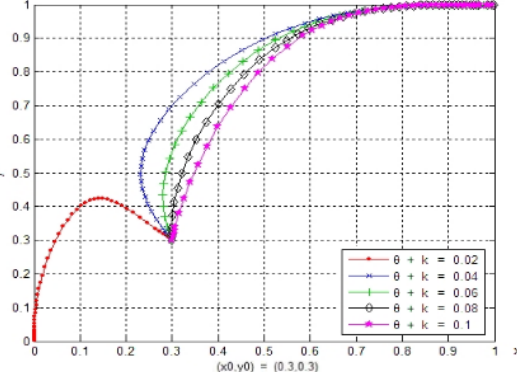
Figure 3. The influence of ( θ + k) changes on the evolution result of the game on both sides of the game.